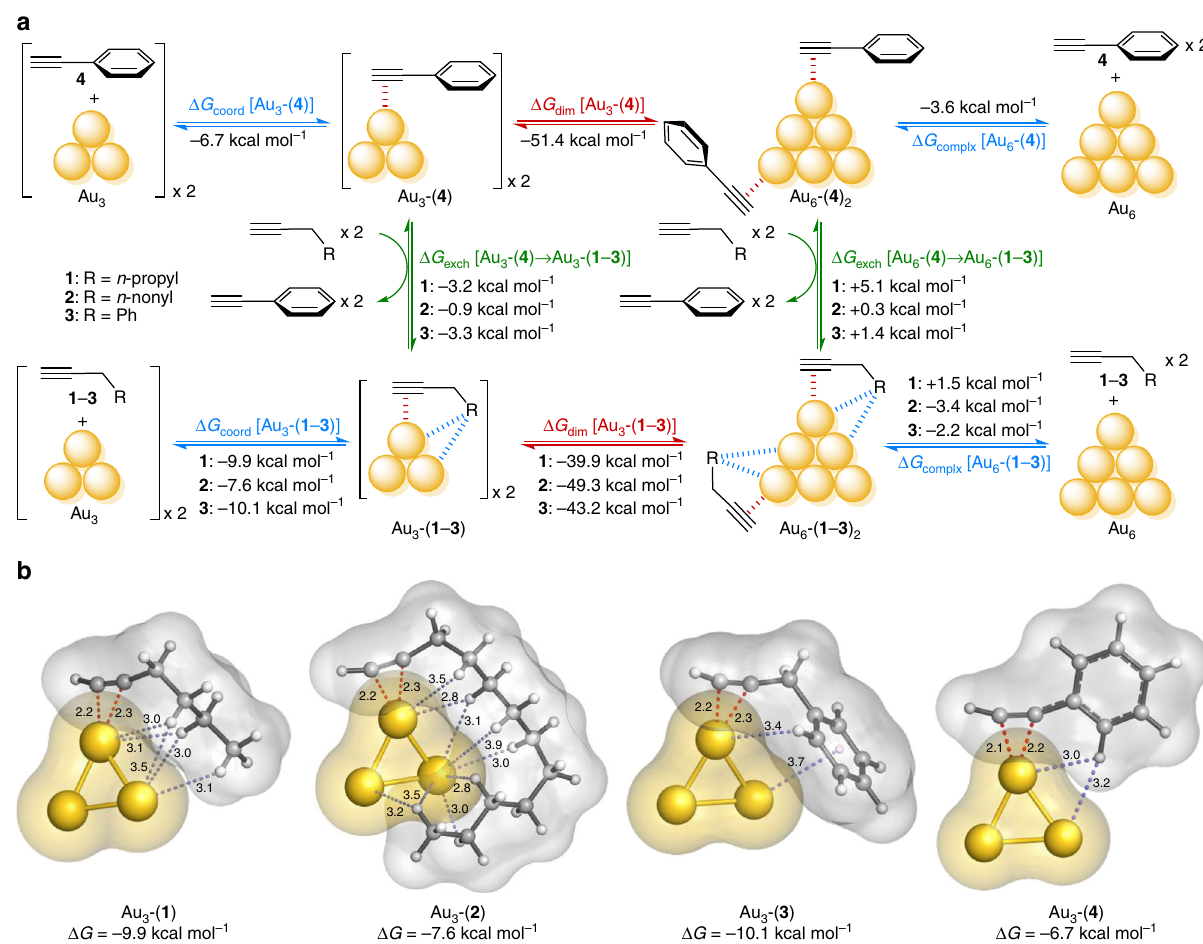
Fig. 4 Quantum mechanical studies of alkyne coordination to gold subnanoclusters. a Calculated thermodynamic cycle for alkyne coordination and Au 3 dimerization. The different coordination abilities of phenylacetylene ( 4 ) and linear alkynes 1-hexyne ( 1 ), 1-docecyne ( 2 ) and benzylacetylene ( 3 ) to Au 3 and Au 6 subnanoclusters are estimated based on the calculated free energies for each equilibrium ( Δ G coord , in blue). The preference of each nanocluster (Au 3 or Au 6 ) to bind the different alkynes is calculated through the corresponding exchange free energies ( Δ G exch , in green). The ability of each alkyne to stabilize small (Au 3 ) or bigger (Au 6 ) subnanoclusters is derived from the calculated dimerization free energies ( Δ G dim , in red). b Minimum energy structures and van der Waals surfaces calculated for Au 3 -( 1 – 4 ) complexes. Interatomic distances between the gold atoms and alkyne (in red) and side chain atoms (in gray) are shown as dashed lines and given in angstrom. Only Au ··· C – H and Au ··· π contacts below 4 Å are shown. See Supplementary Fig. 9, Supplementary Table 3, and Supplementary Methods for further